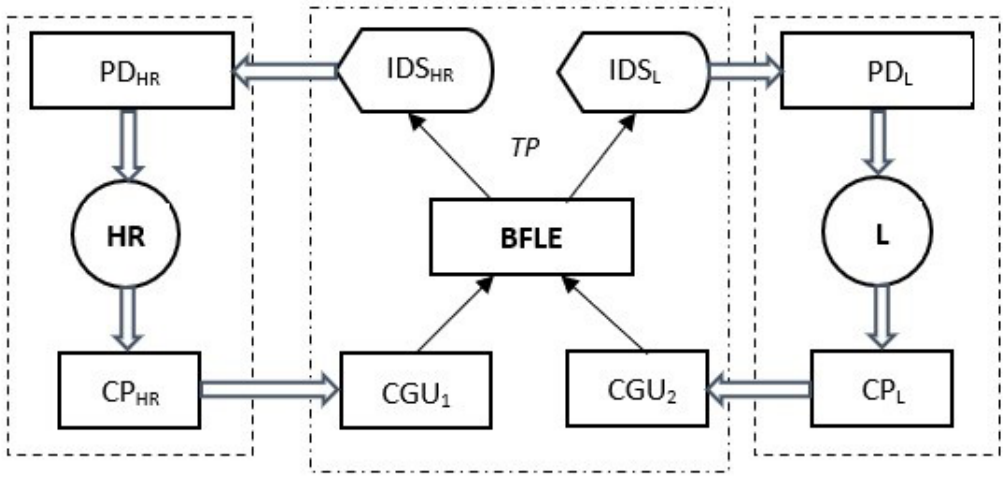
Figure 3: Generalized biotechnical system with one